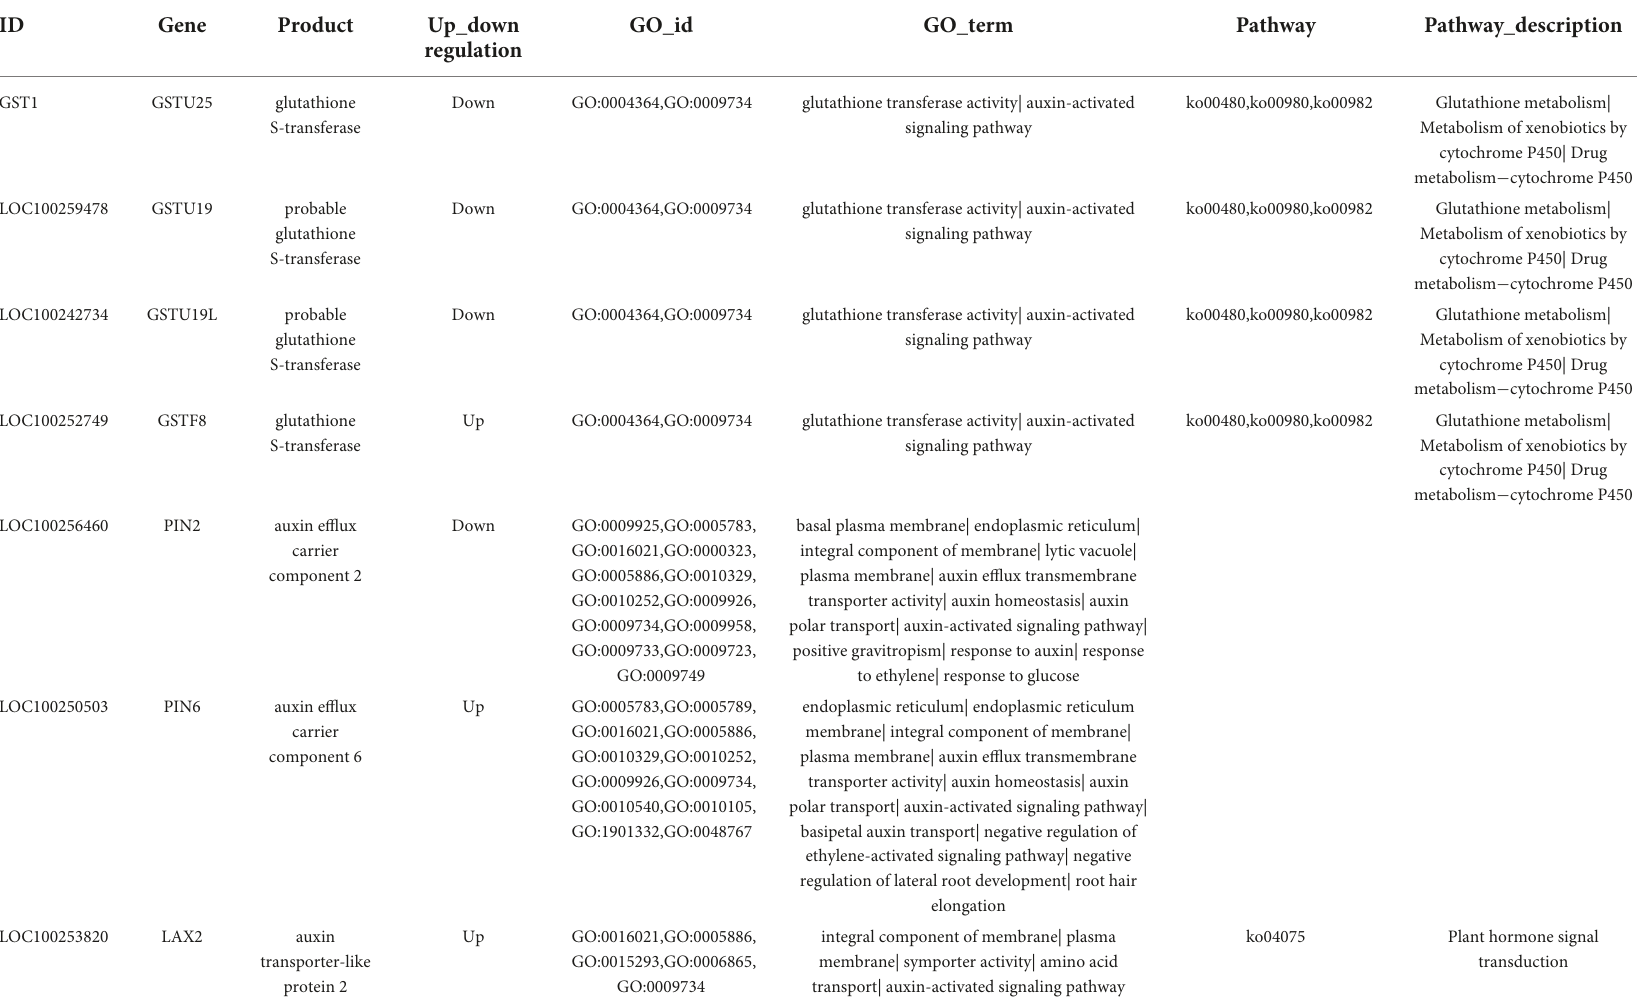
TABLE 2 The annotation information of differentially expressed genes in response to plant hormones auxin (IAA), abscisic acid (ABA), ethylene (ETH), gibberellin (GA), brassinolide (BR), and cytokinins (CTKs) after root restriction